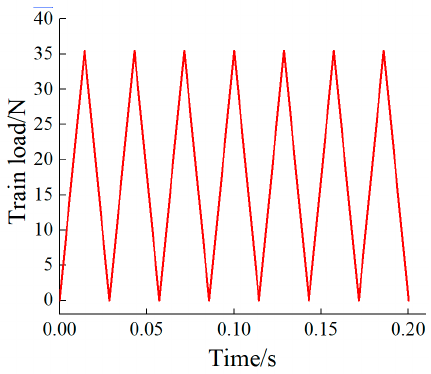
Figure 13. Simulated train load.